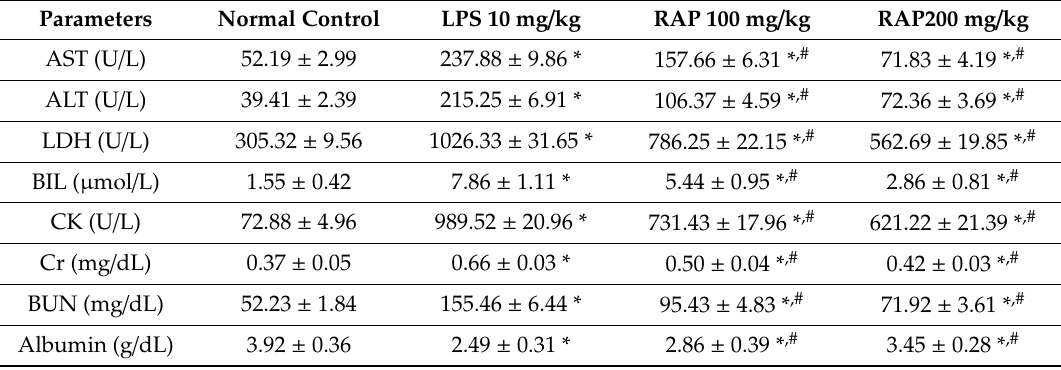
Table 1. Biochemical assessment between normal and inflammatory rats treated with di ff erent dose of RAP.